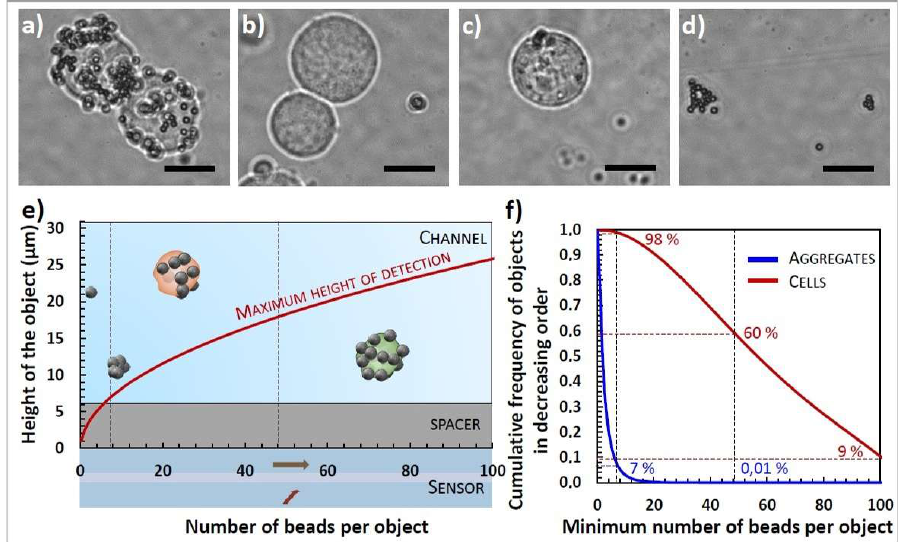
Figure 5. Labeling and aggregation study. Four sample photographs (magnification 100) were taken under optical microscope and illustrate beads repartition. (The scale bars represent 5 µ m.) ( a ) Group of two NS1 cells labeled with Dynabeads MyOne functionalized with anti-CD138 mAbs. ( b ) Group of two NS1 cells after two hours-contact with Dynabeads MyOne functionalized with control IpaD-315 mAbs. ( c ) CHO cell after two hours-contact with Dynabeads MyOne functionalized with anti-CD138 mAb ( d ) Dynabeads MyOne functionalized with anti-CD138 mAbs in Phosphate Buffer Saline (PBS). ( e ) Adapted spacer layer thickness estimation. In this illustration, the detectivity is set to 2.2 µ T. Relation between the number of beads covering an object and the maximum height at which it can be detected. Objects below the red curve are detectable while objects above are not. ( f ) Corresponding detectable population of cells and aggregates. Graph of the observed cumulative frequency of the number of MPs per NS1 cell and per aggregate in decreasing order. Estimation based on the study of 309 cells in a solution containing 10 5 NS1/mL and 23 µ g/mL anti-CD138 functionalized MPs/mL after 2h-contact and of 18,630 aggregates in a suspension containing 23 µ g/mL anti-CD138 in